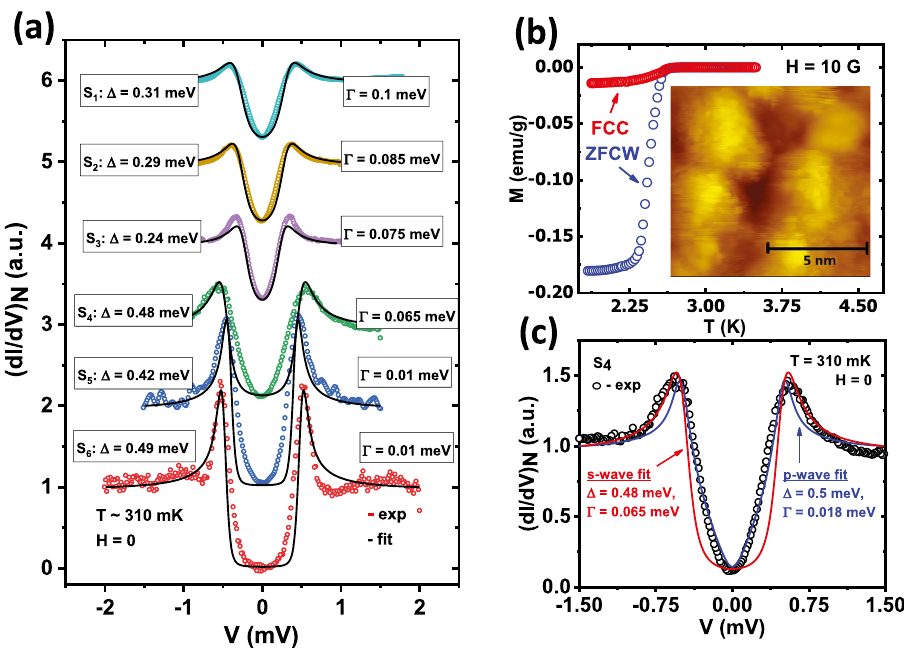
Figure 1. ( a ) Six representative tunneling spectra ( S 1 – S 6 ) plots (color points) along with corresponding numerically generated spectra under single gap s -wave model (black lines). The extracted fitting parameters (cid:31) and Ŵ are also shown for each spectrum. ( c ) Spectrum S 4 with both best single gap ‘ s -wave’ and ‘ p -wave’ fit along with the corresponding extracted parameters. The temperature ( T ) 310 mK for all spectra. ( b ) Bulk ∼ magnetization ( M ) data in both zero field cool warming (ZFCW) and field cool cooling (FCC) condition with 10 G magnetic field. Inset : STM topographic image of the